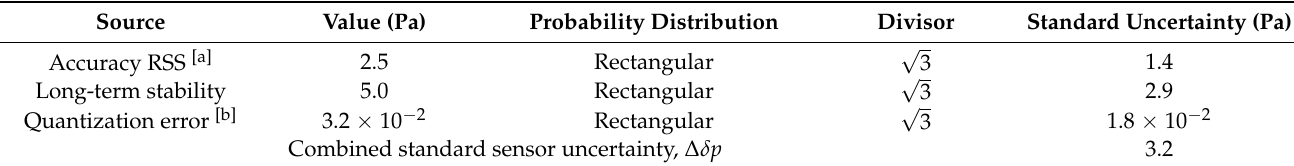
Table 6. Uncertainty budget for differential pressure